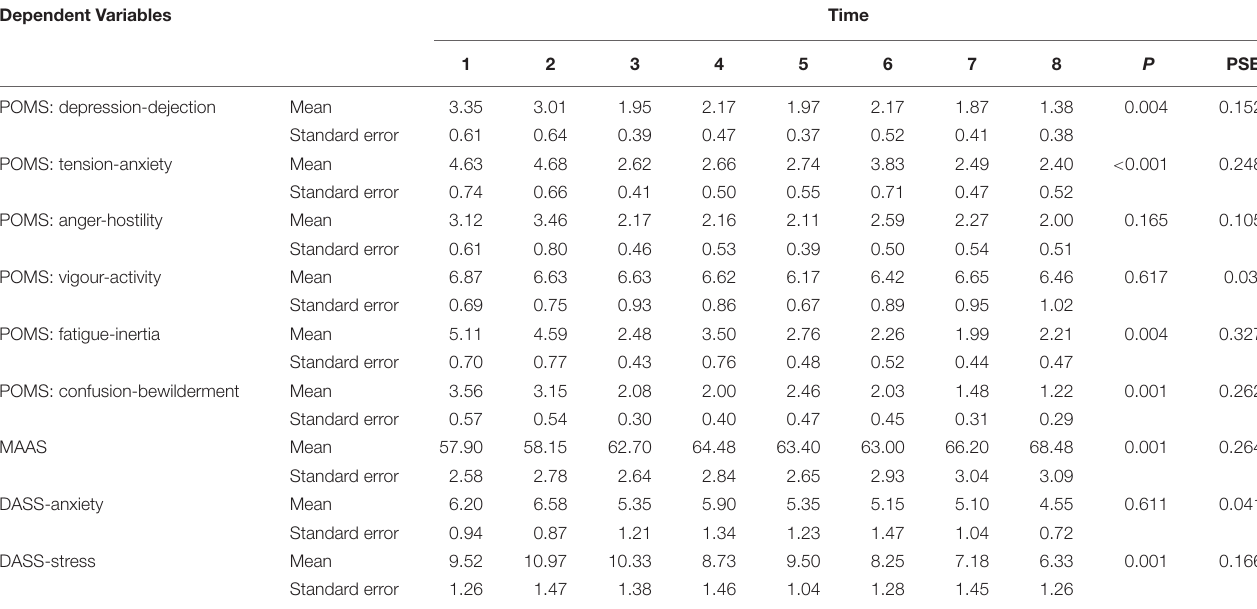
TABLE 4 | Mean and standard errors and partial eta squared (PES) for the main effect of Time for the POMS, MAAS and DASS questionnaires for the intervention group and control group. Dependent Variables